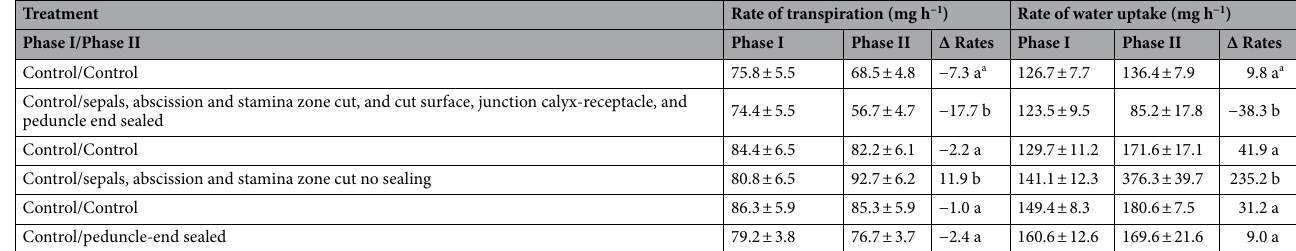
Table 1. Rates of water uptake and transpiration along different pathways of strawberry cv. Sonsation. The experiment was conducted in two phases using a repeated-measures design. During phase I (incubation for 0–1.5 h) uptake and transpiration were determined without any treatment (‘control’). During phase II (incubation in water for 3–4.5 h), the remains of floral parts were excised, or parts of the fruit surface sealed using silicone rubber. Phase II treatments comprised the excision of sepals and stamina and subsequent sealing of the cut surfaces, the calyx-receptacle junction and peduncle surface including the peduncle end (‘Control/ sepals and stamina cut, and junction calyx-receptacle and peduncle end sealed’), the excision of sepals and stamen without subsequent sealing of the cut surfaces (‘Control/sepals and stamina cut, no seal’), and sealing of the cut peduncle end (‘Control/peduncle-end sealed’). Fruit without excision and without sealing served as controls (‘Control/control’). a Mean separation within main effect by Dunnett’s test at p = 0.05. Each treatment was compared with its